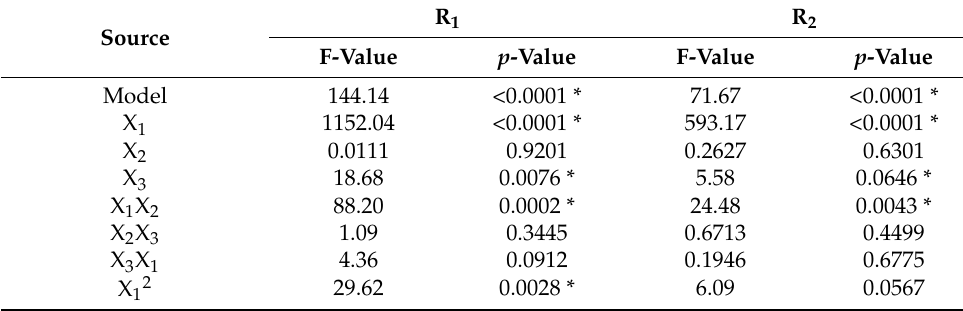
Table 2. Results of statistical analysis of dependent